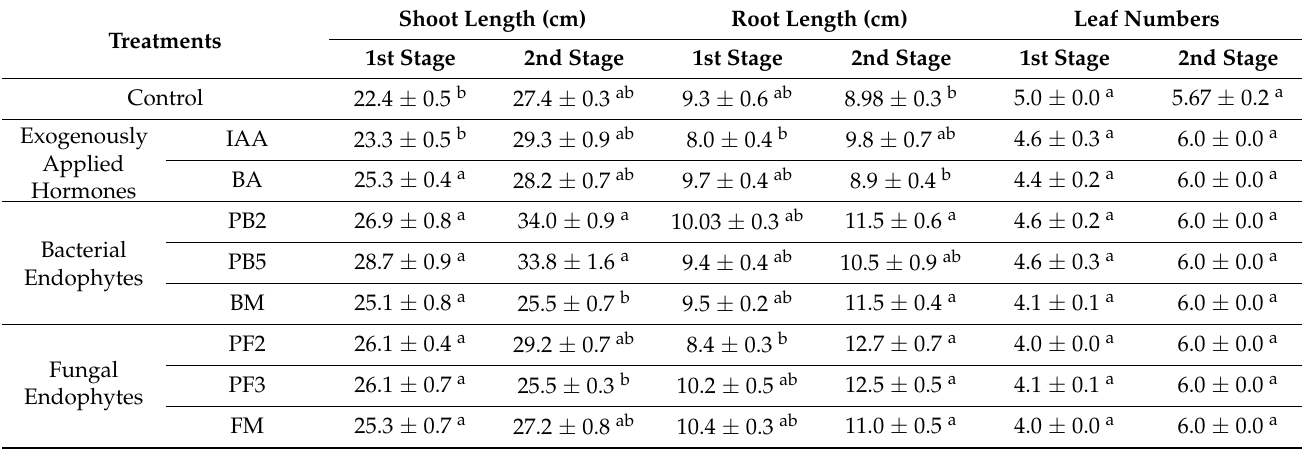
Table 3. Effect of foliar spraying of exogenously applied hormone and microbial endophyte metabolites on root, shoot length and leave numbers of common bean